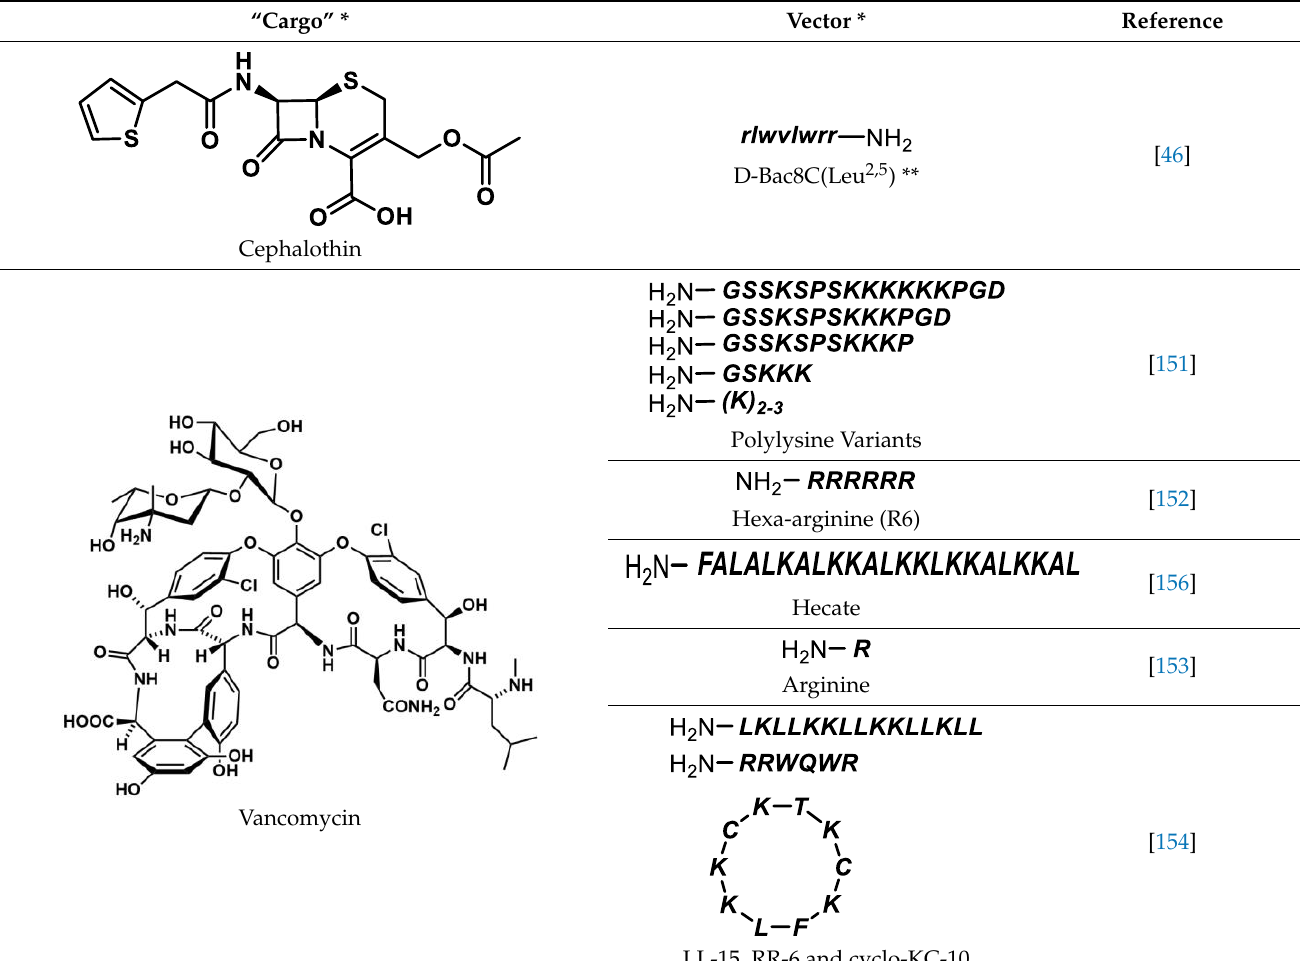
Table 1. Structures and peptide sequences for the conjugates discussed in this review. “Cargo” and Vector represent the major functional moieties in the conjugates. (for clarity, linkers have been omitted). “Cargo” *